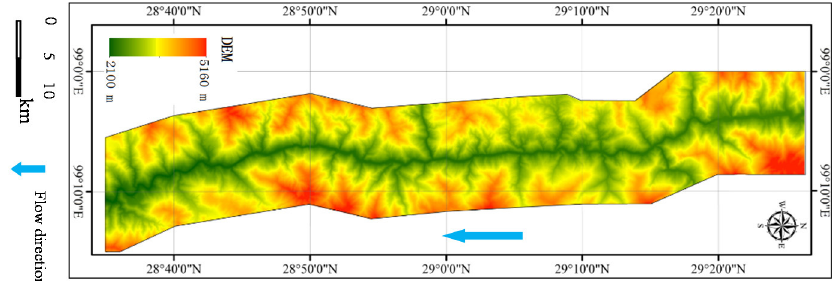
Figure 4. The digital elevation model of reservoir in Xulong hydropower station.